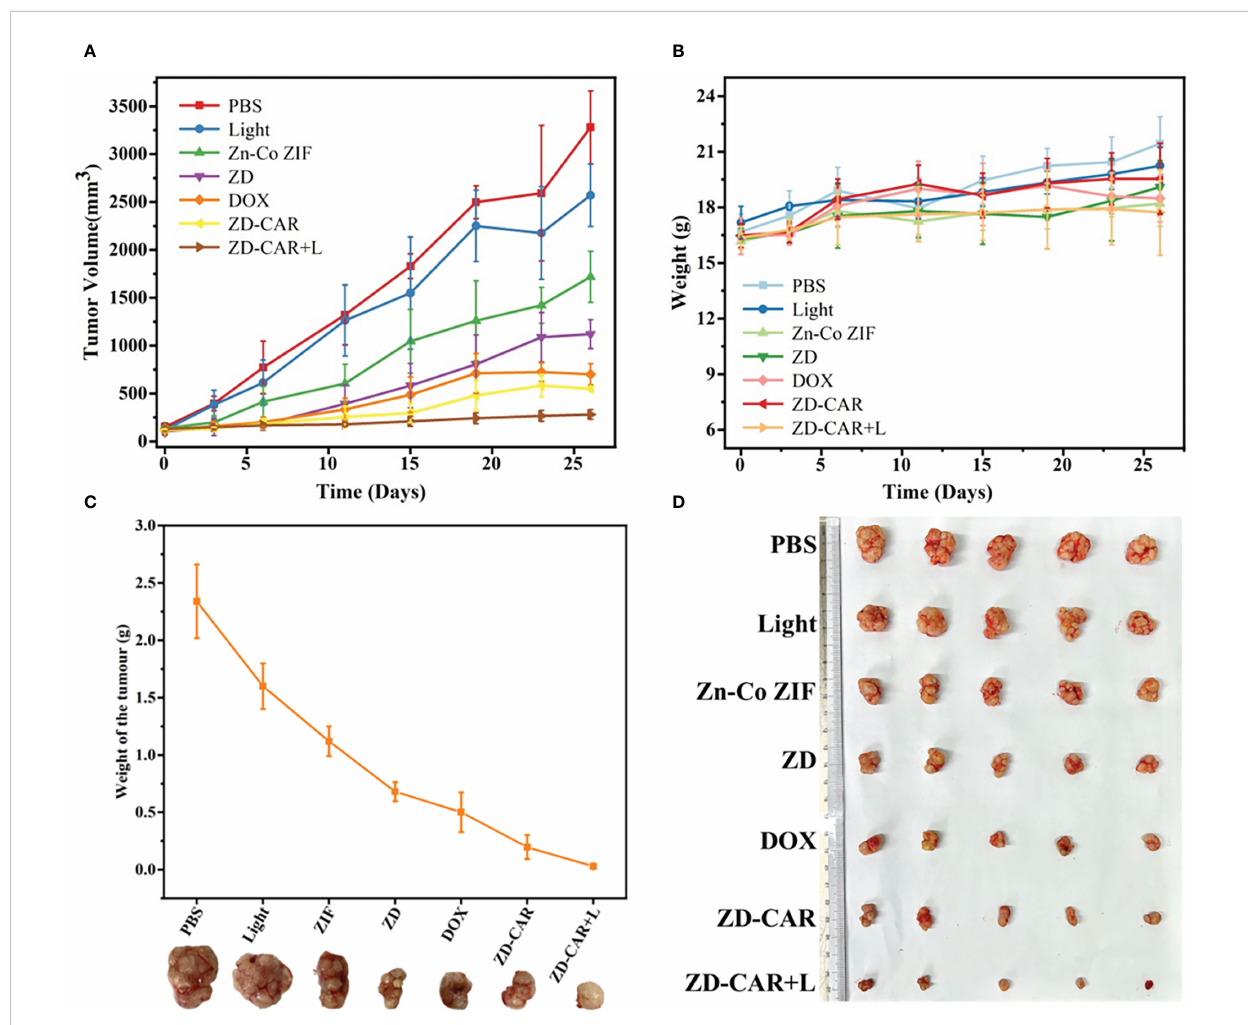
FIGURE 12 (A) The change curve of tumor volume in mice treated with different materials; (B) Body weight change curve of mice treated with different materials; (C) The change in weight of the tumour after removal of the tumour after treatment with different materials; (D) Tumours dissected from mice after